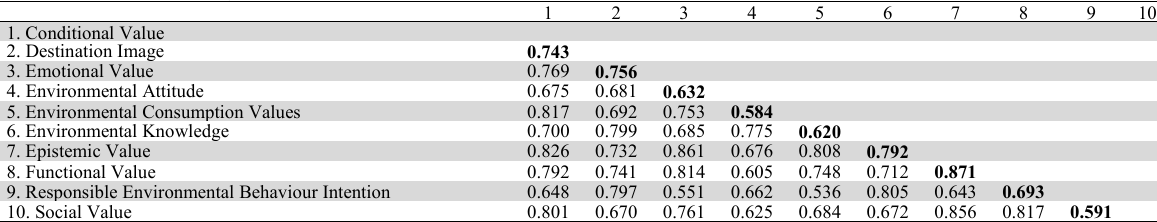
Discriminant Validity (HTMT